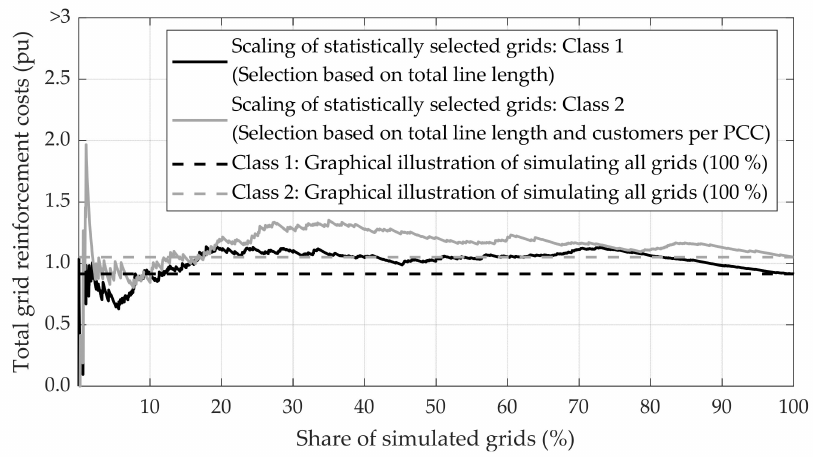
Figure 12. Comparison of scaling statistically selected LV grids’ results for two grid classes, classified according to the total line length and the number of customers per point of common coupling